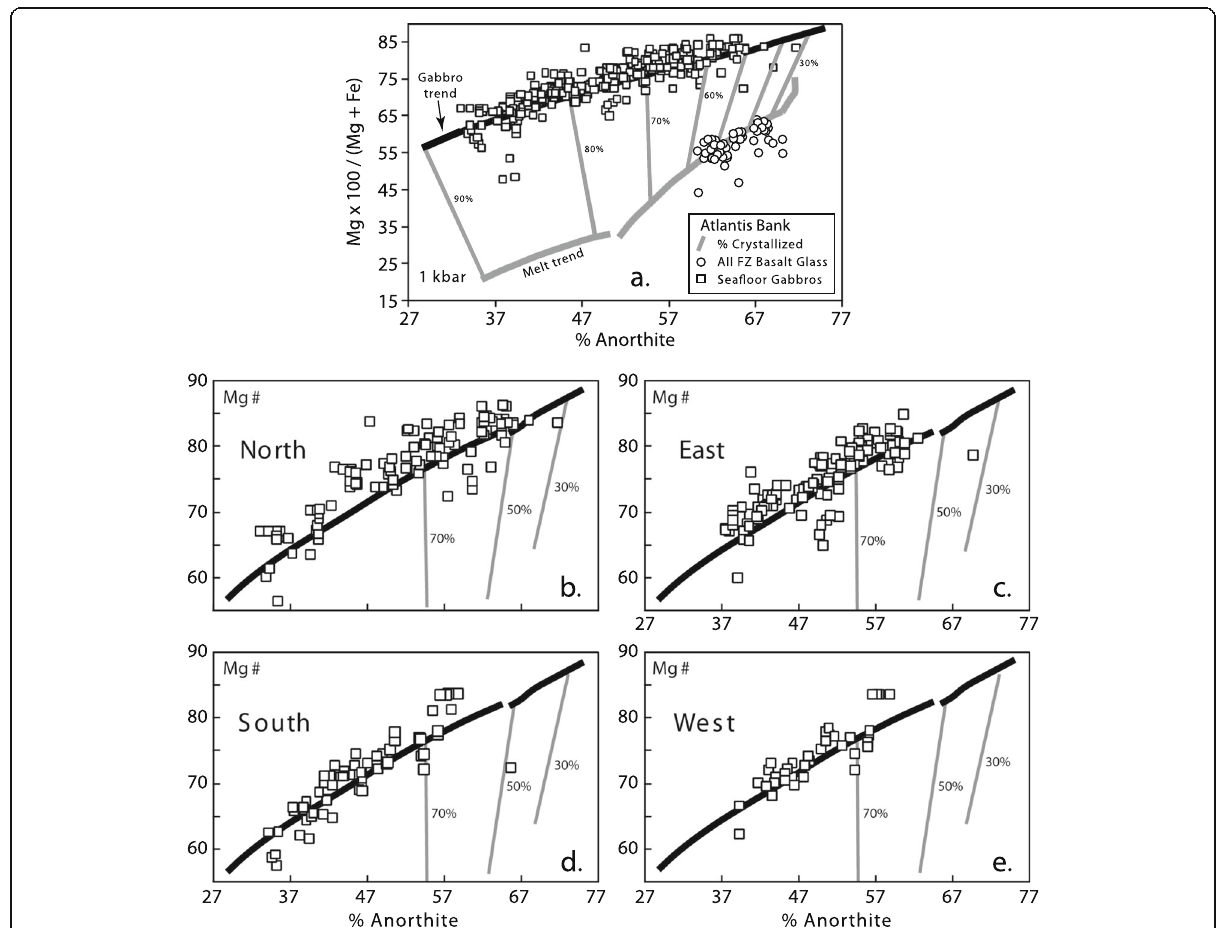
Fig. 19 The distribution of Atlantis Bank mineral compositions relative to modeled liquid and solid lines of descent modeled for 1 kb using Ghiorso and Sack (1995). Gray bars connect equilibrium melt and plagioclase compositions using the most primitive MORB glass from Dick et al. (2000) as a starting composition for 30 – 90% crystallization. a Atlantis Bank seafloor gabbro sample plagioclase anorthite contents (upper data array) and Ca × 100/(Ca + Na) for present day ridge segment glasses (lower array) plotted against the coexisting augite and glass Mg#. b – e The predicted solid line of descent from panel a and the plagioclase and augite compositions for the northern, eastern (top of bank), southern, and western regions,